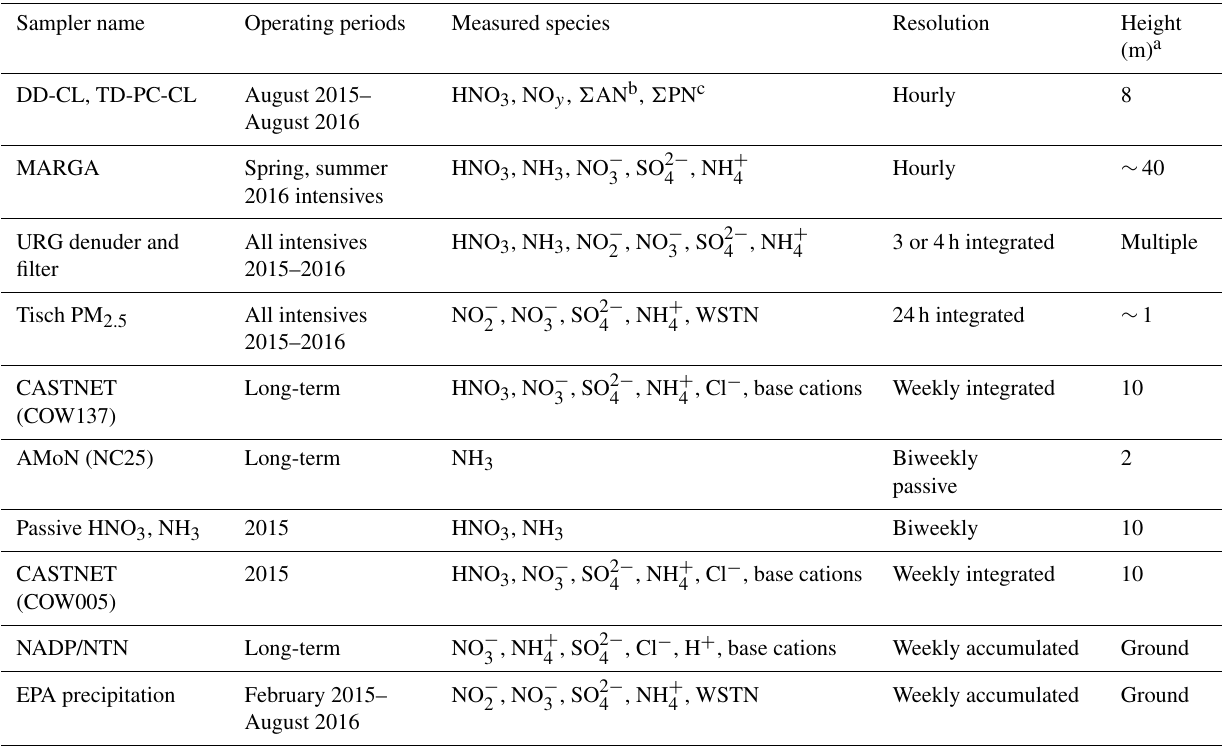
Table 2. Details of intensive and long-term atmospheric measurements at